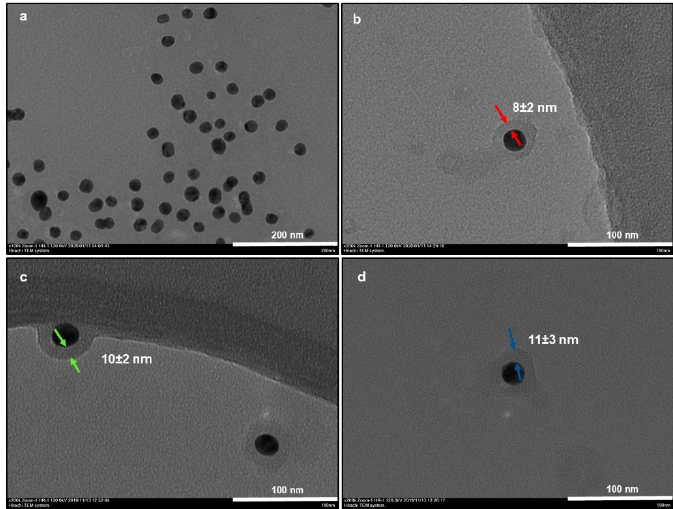
Figure 1. TEM images (( a ): bare AuNP, ( b ): AuNP@30PDOP, ( c ): AuNP@60PDOP, and ( d ):